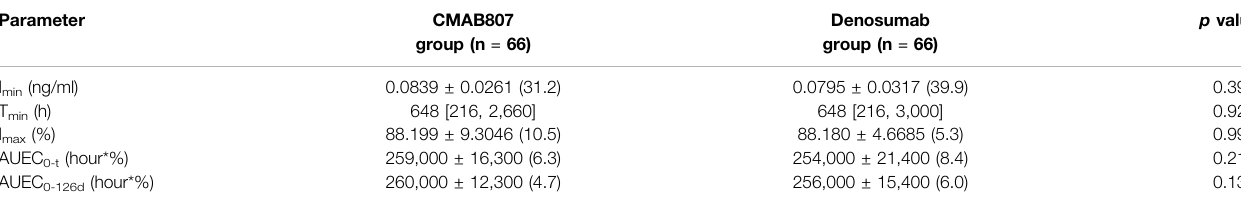
TABLE 3 | Pharmacodynamic parameters of CTX1 in each group (means ± SD (CV%) or medians [min, max]).